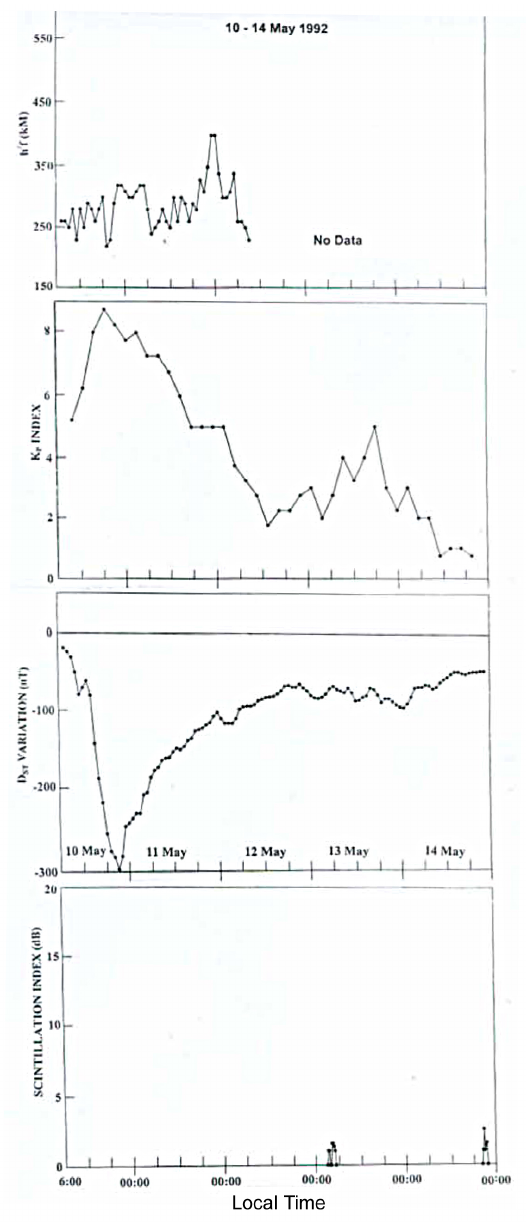
Fig. 13. Example of a magnetic storm that occurred during 10 − 14 May 1992. The top panel is ionospheric F-layer height (h 0 F) at Ahmedabad, the two middle panels are K p and D st and the bot- tom panel shows the occurrence times of scintillation activity at